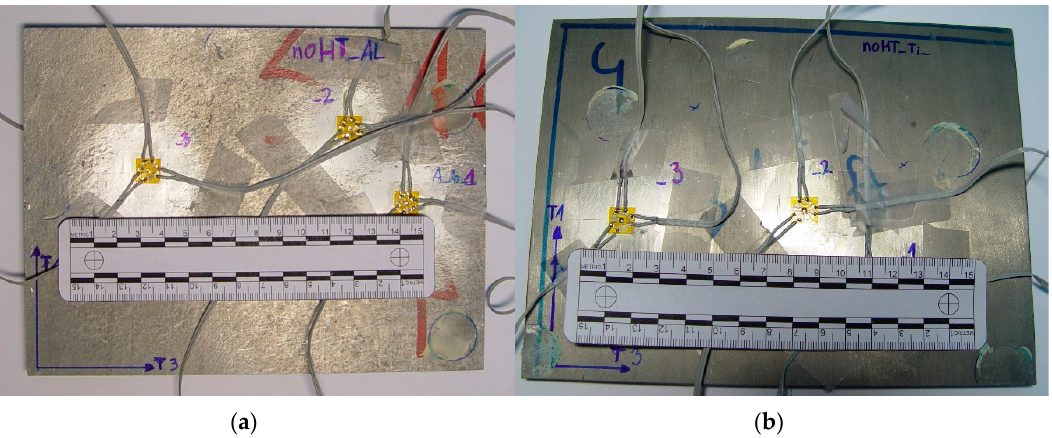
Figure 12. Emplacement of measuring rosettes on a section of the AA2519-Ti6Al4V laminate plate in the initial state: on the aluminum alloy side ( a ), on the titanium alloy side ( b ). The resulting output signal registered in the respective depths of the bore was then converted to strain values in accordance with Equation (2).